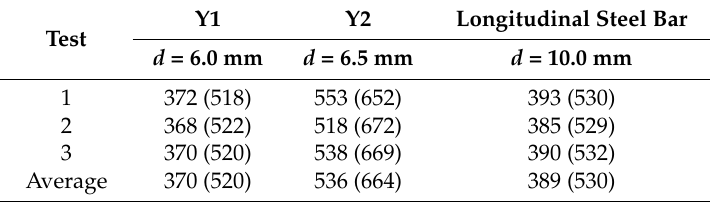
Table 3. Yield tensile strength (ultimate tensile strength) of stirrups and longitudinal steel bars (MPa).